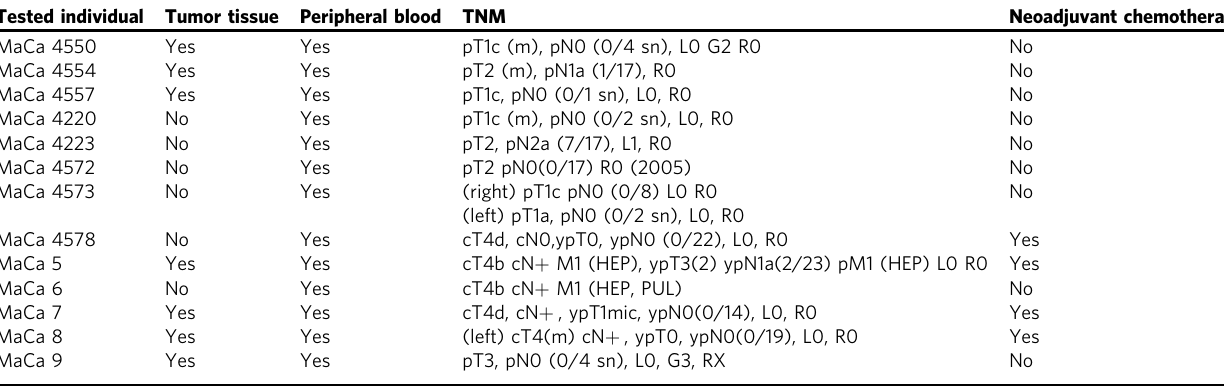
Table 1 TNM stage, previous treatment, and tissue analyzed from tested breast cancer patients upon tumor resection. Tested individual Tumor tissue Peripheral blood